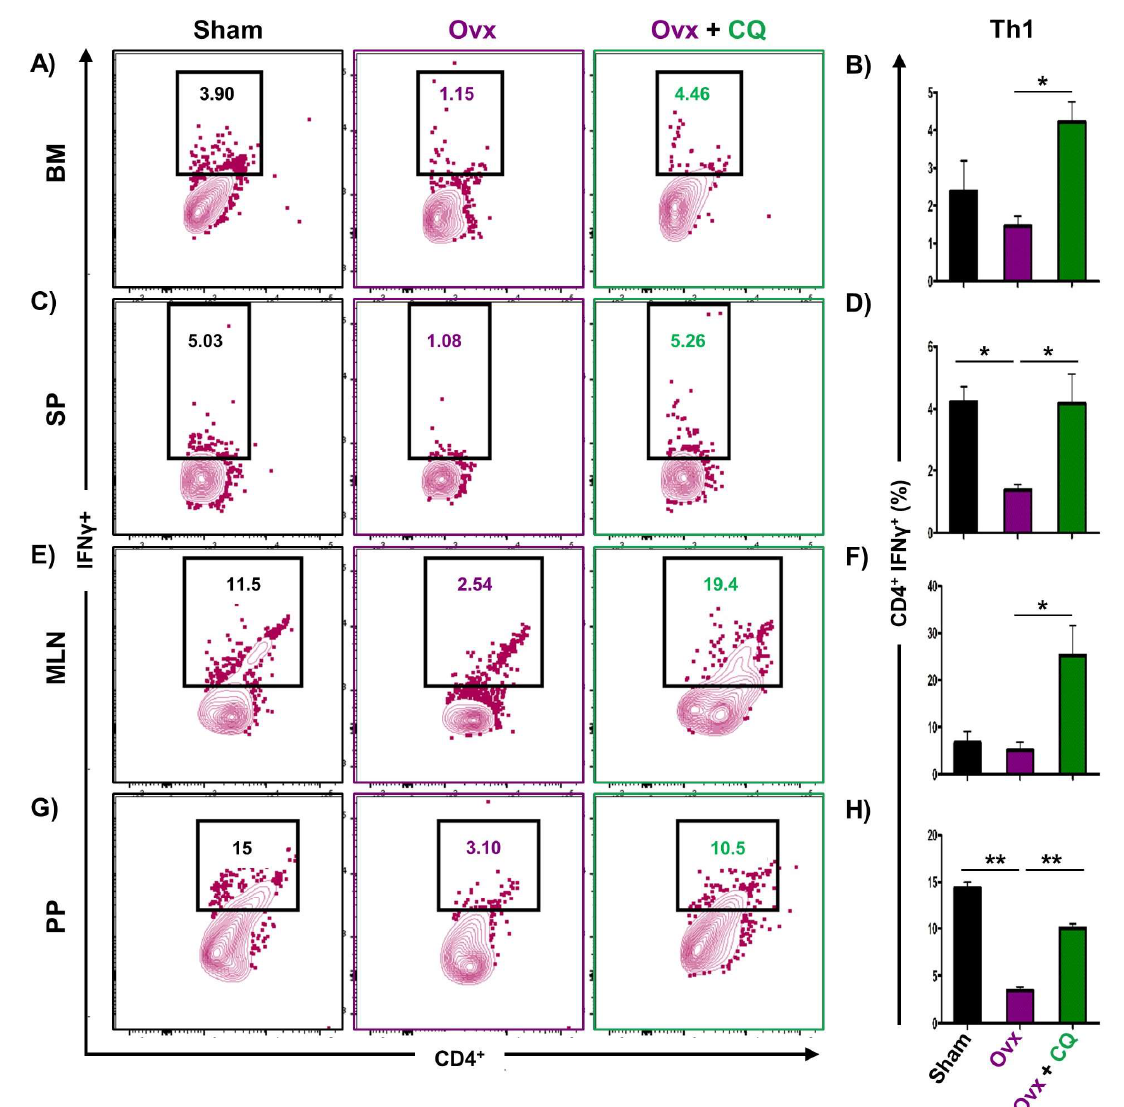
Figure 5. CQ administration enhances Th1 cells in Ovx mice : Immune cells harvested from the lymphoid organs of all the groups were analyzed by flow cytometry for the percentage of CD4 + IFNγ + Th1 immune cells. ( A ) Contour plot representing the percentage of CD4 + IFNγ + Th1 in BM. ( B ) Bar graphs representing the percentage of CD4 + IFNγ + Th1 in BM. ( C ) Contour plot representing the percentage of CD4 + IFNγ + Th1 in SP. ( D ) Bar graphs representing the percentage of CD4 + IFNγ + Th1 in SP. ( E ) Contour plot representing the percentage of CD4 + IFNγ + Th1 in MLN. ( F ) Bar graphs representing the percentage of CD4 + IFNγ + Th1 in MLN. ( G ) Contour plot representing the percentage of CD4 + IFNγ + Th1 in PP. ( H ) Bar graphs representing the percentage of CD4 + IFNγ + Th1 in PP. ANOVA was used to analyse the results, and then unpaired Student t-tests were used to compare the indicated groups. Values are expressed as mean ± SEM, and equivalent outcomes were observed in two independent experiments. For the indicated groups, p 0.05 (* p ≤ 0.05, ** p ≤ 0.01) was used as the cutoff for statistical significance.